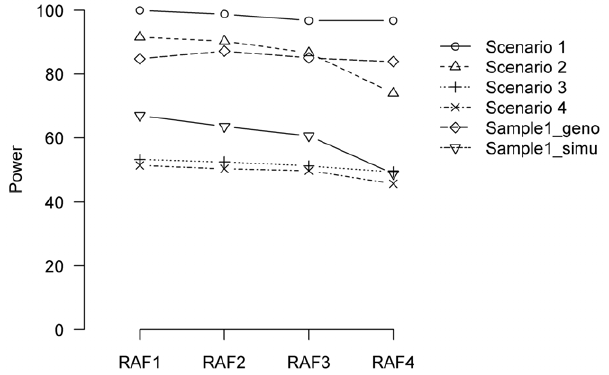
Figure 3. Power comparison between meta-analysis of differ- ent scenarios and association analysis in individual Sample 1. Sample1_geno and Sample1_impu refer to situations where causal SNPs are typed and imputed, respectively, in Sample 1. QTL variation of 2.0% is used.